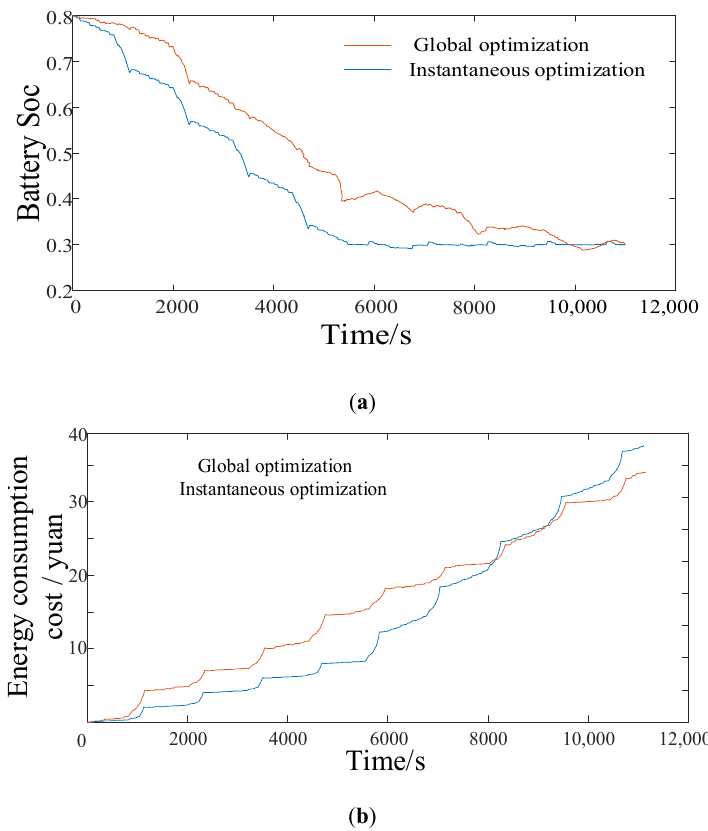
Figure 17. Comparison of simulation results under two strategies: ( a ) battery SOC versus time curve; ( b ) energy consumption cost versus time